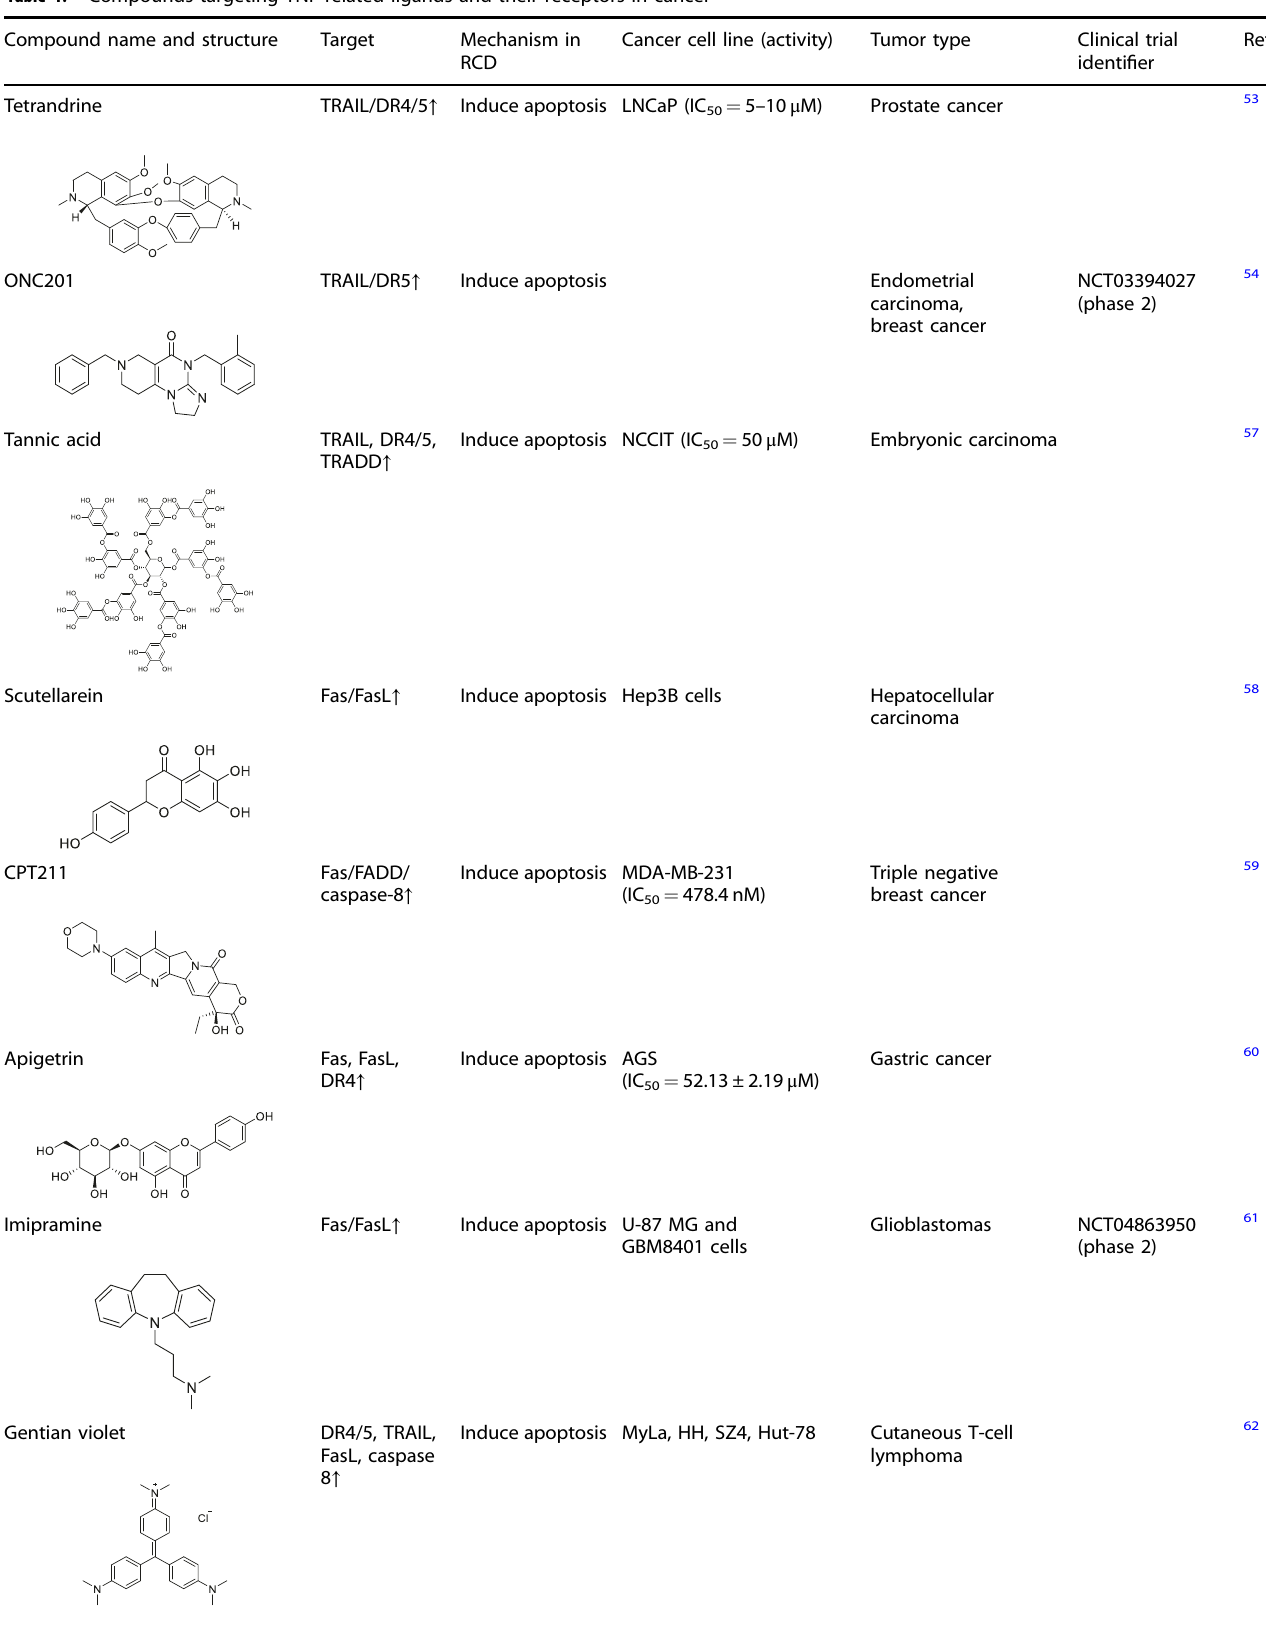
Table 1. Compounds targeting TNF-related ligands and their receptors in cancer Compound name and